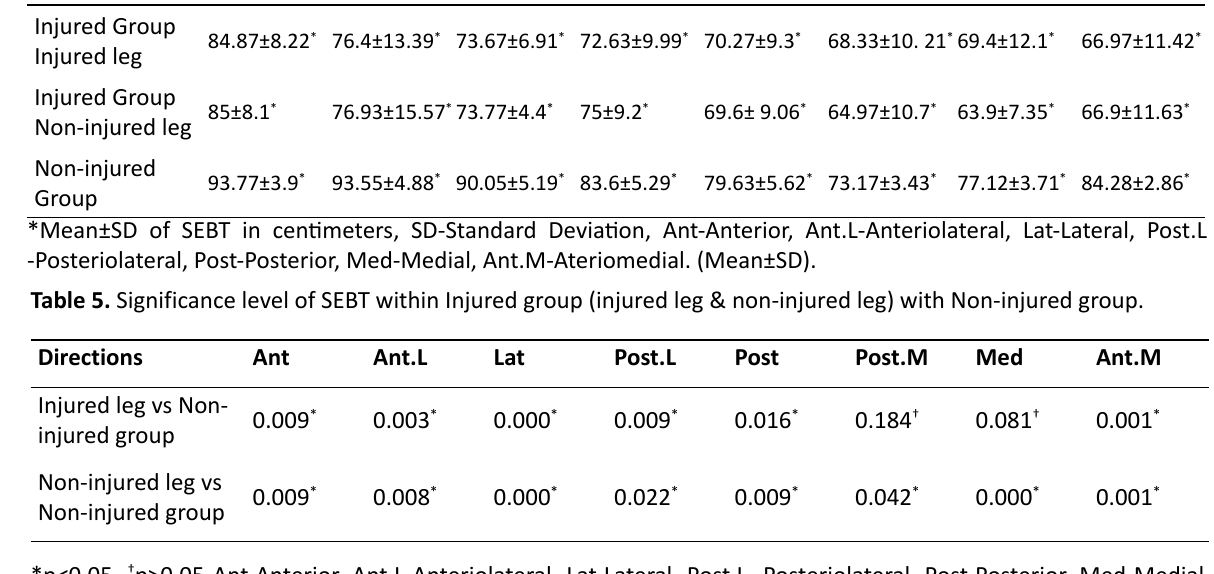
Table 4. Comparison of SEBT (Mean±SD) within Injured group (Injured leg & non-injured leg) with Non-injured group. Directions